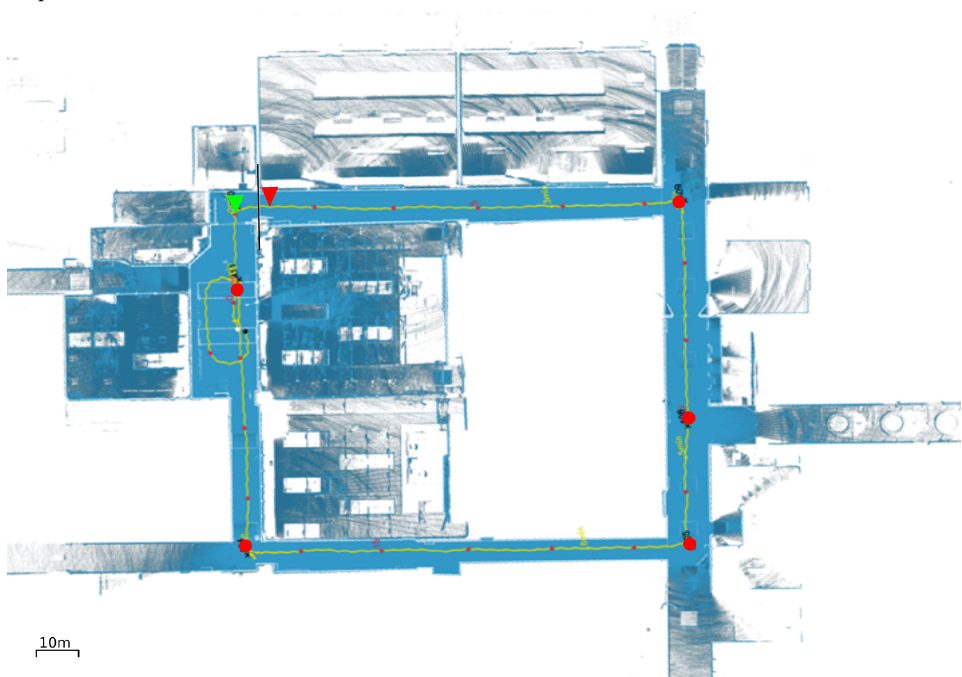
Figure 3. Overview of the test setup for the sensor capacity tests: (green triangle) starting point (red triangle) end point, (yellow) trajectory and (red) control points of testsite ( a ) D-hall and ( b )